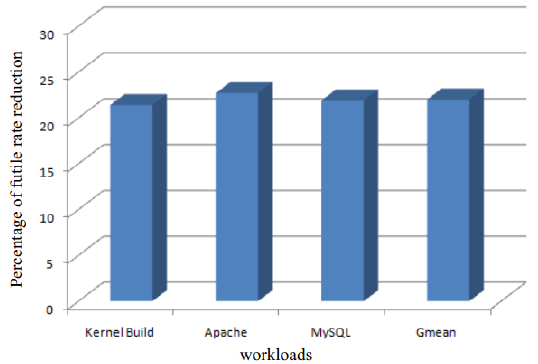
Figure 14. The percentage rate reduction of unnecessary comparisons with four VMs, where the baseline is from the KSM